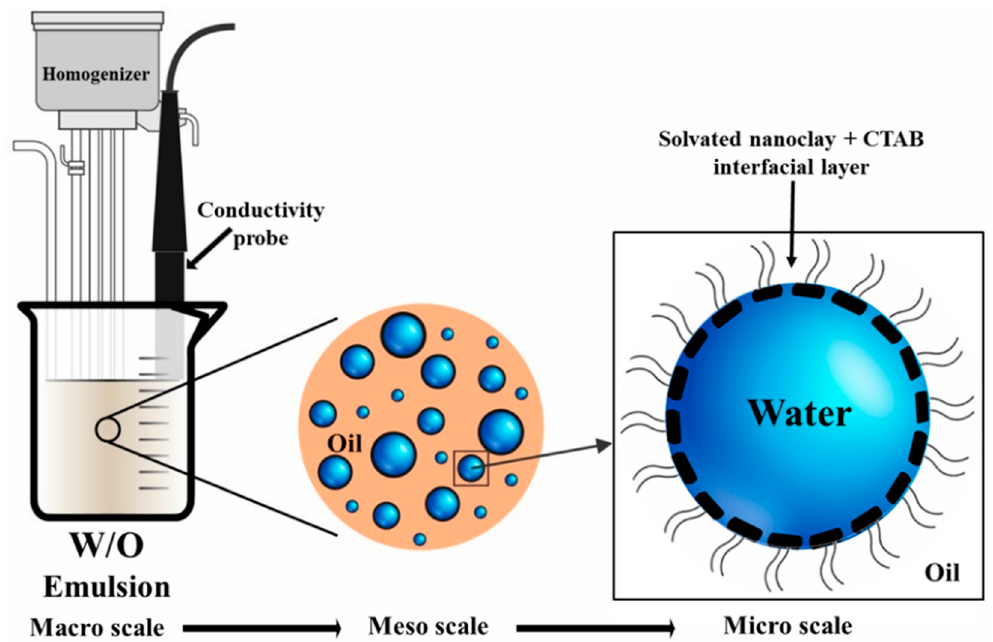
Figure 1. Schematic of a multiscale water-in-oil (W / O) emulsion system, with an emphasis on water droplets stabilized by surfactant-modified nanoclay. Note: CTAB = cetyltrimethyl ammonium bromide.